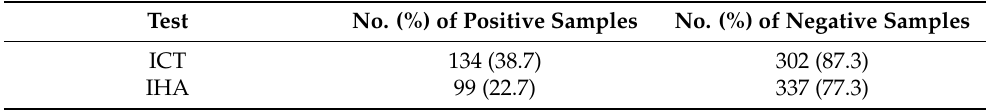
Table 3. Comparing the percentage of positive and negative samples detected by the ICT and IHA methods.